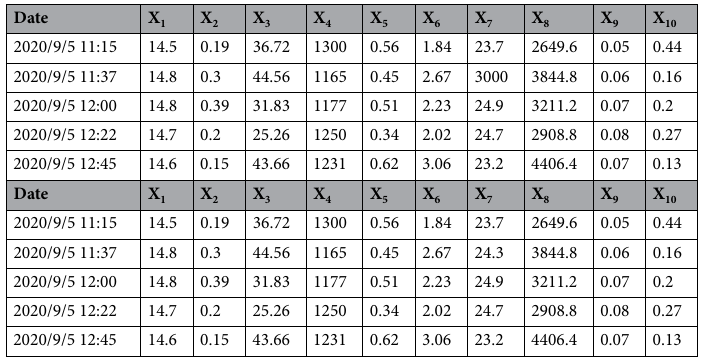
Table 2. Comparison table before and after outlier